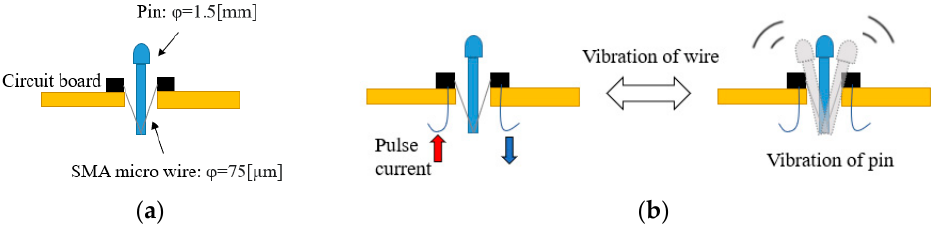
Figure 4. Structure of SMA actuators. ( a ) Structure of pin-type tactile actuator driven by SMA wire. ( b ) Stimuli presented by vibrating pin.